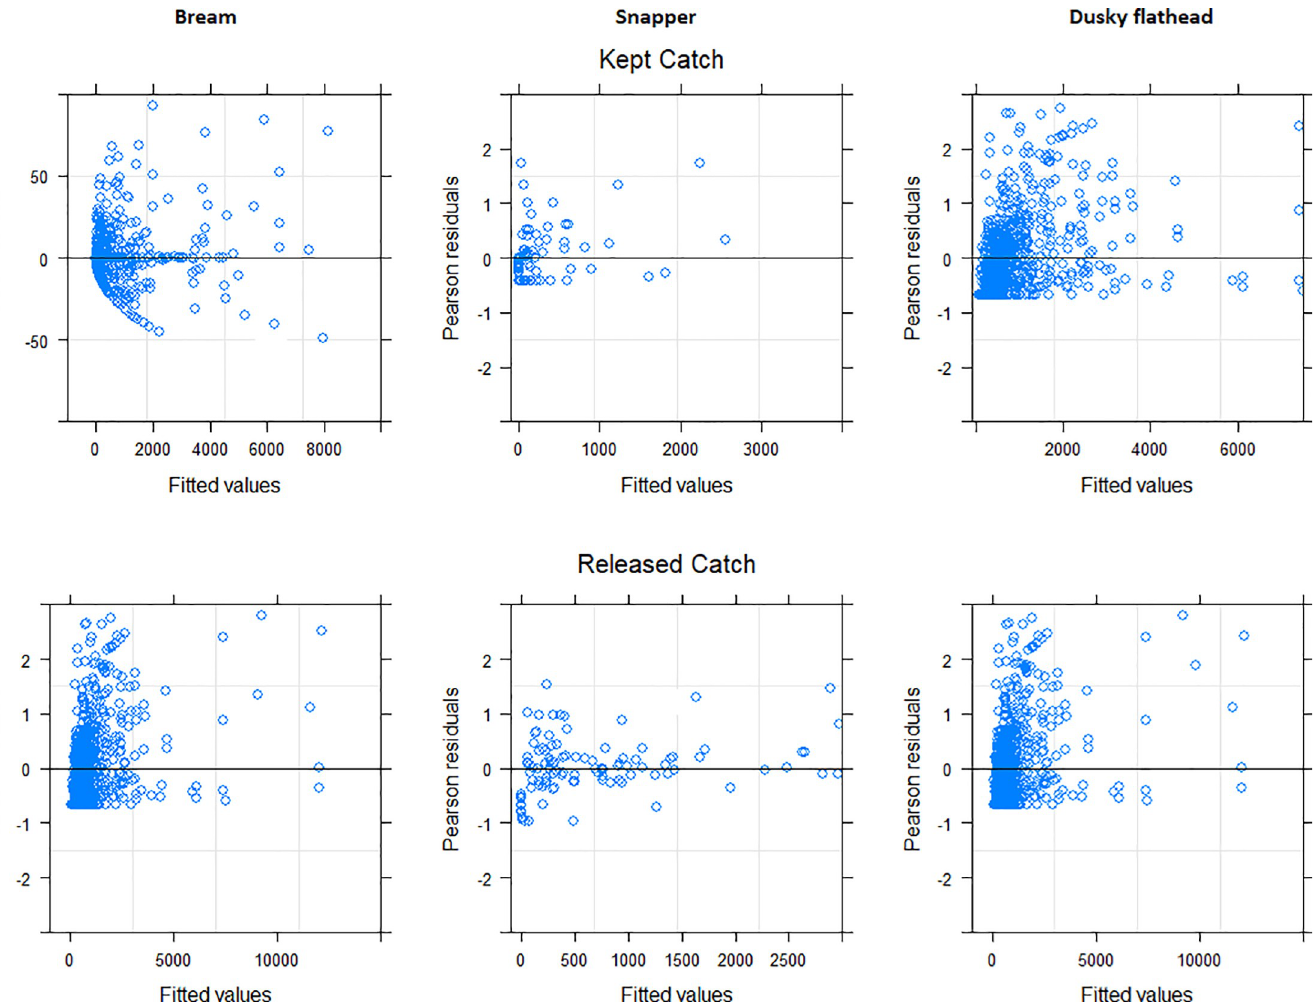
Fig 2. Pearson residual plots used to assess the fit of generalized linear mixed effects models that examined the influence of the categorical variables zone (6 levels: North Coast, Mid-North Coast, Hunter, Sydney, Mid-South Coast and South Coast) and/or season (4 levels: Autumn, Spring, Summer, Winter) on the number of estuary-caught bream, snapper and dusky flathead, that were kept and released from recreational fishing activity in NSW waters during 2013/14. Each model assumes a negative binomial